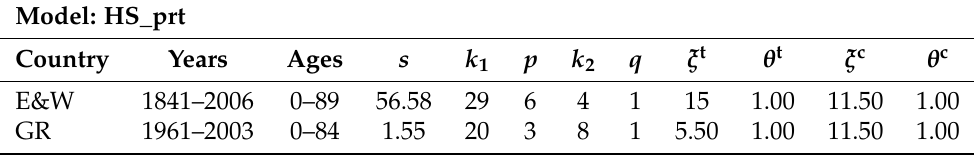
Table 8. Optimum parameters for HS_prt structure for the E&W and GR shorter datasets. Model: